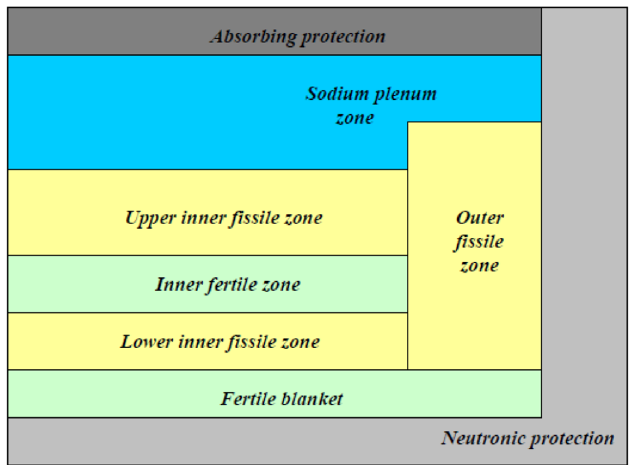
Fig. 1. CFV general core geometry. On the left: radial cut (cid:1) at the center the inner zone and the outer zone at the periphery